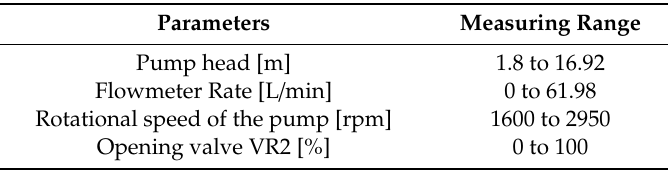
Table 1. Measuring range of test parameters.